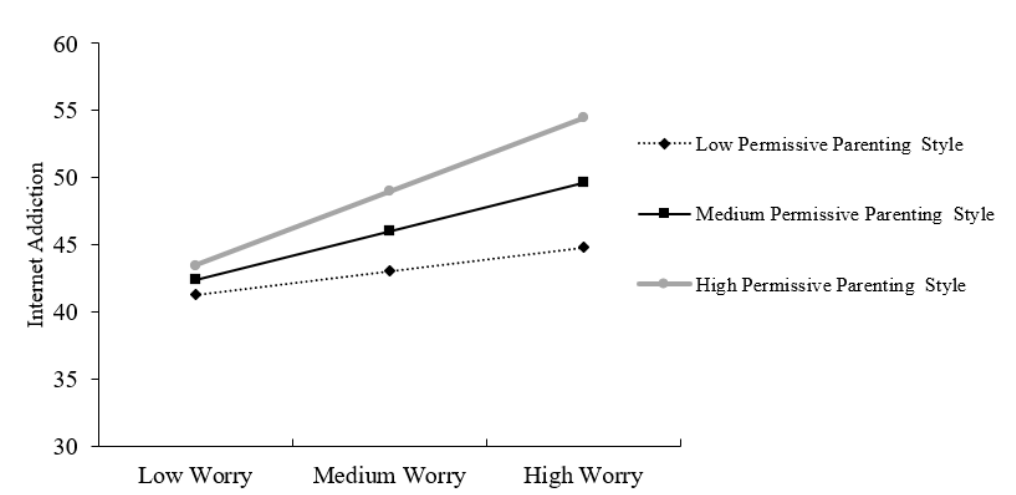
Figure 2. Simple slopes for the effect of worry on Internet addiction at low, medium, and high levels of the permissive parenting style.